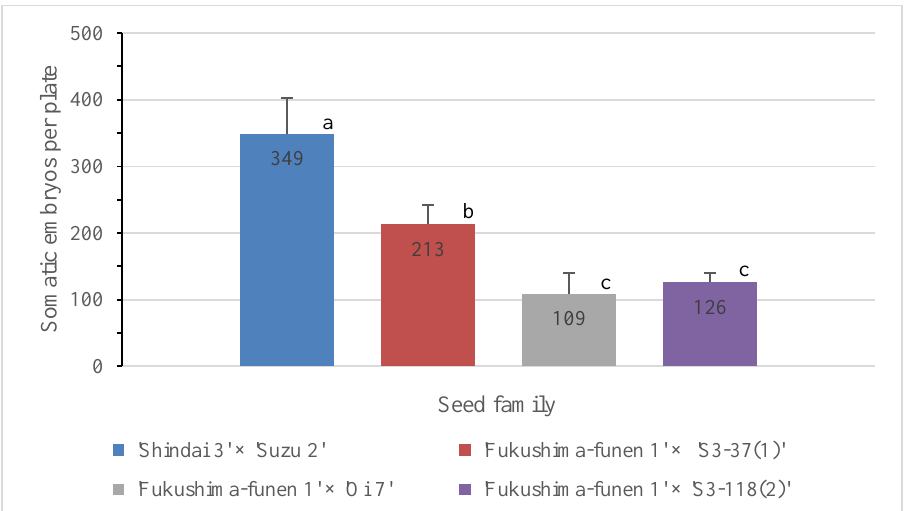
Figure 4. Somatic embryo production efficiency of sugi seed families carrying the male sterility gene MS1 . Data represent the mean ± SE of somatic embryos per plate (cotyledonary embryos per 0.5 g) from ten male sterile lines per seed family. The lower case letters indicate significant differences according to Tukey’s multiple range test at p < 0.05.